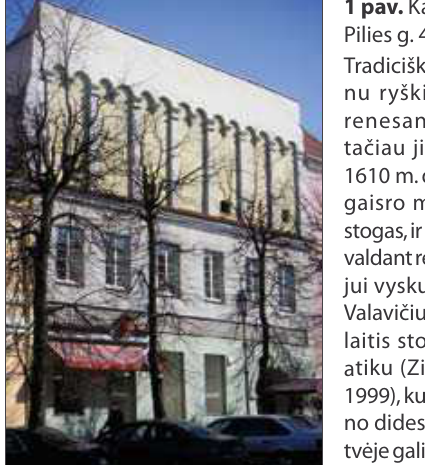
Fig. 1. House of Capiluta in Pilis st 4